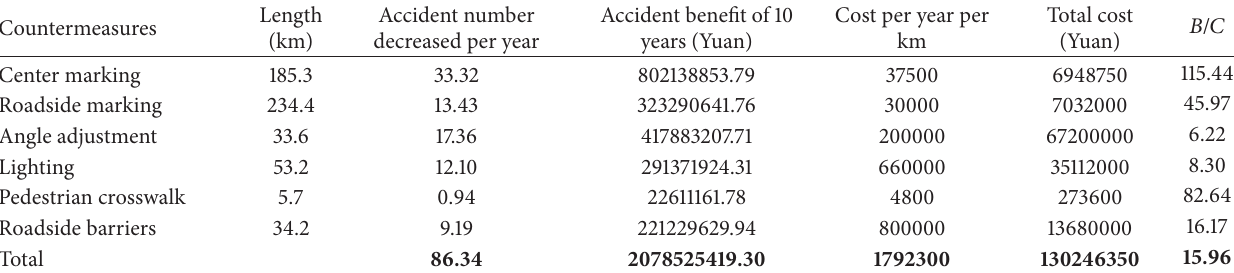
Table 8: Investment plan summary.